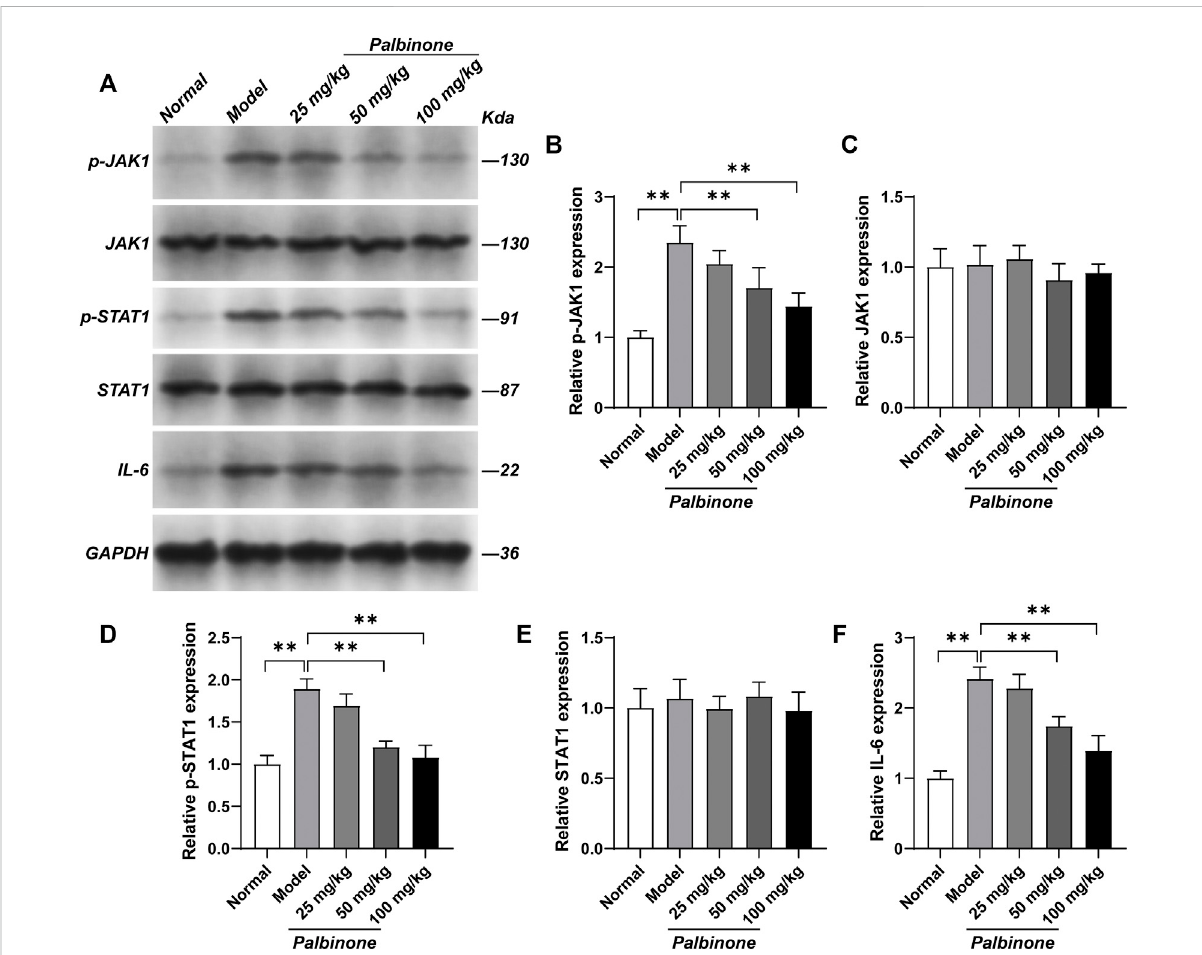
FIGURE 7 The effects of PB on JAK1-STAT1 signalling pathway in collagen-induced arthritis rats. Rats were given via intradermal injection of 100 µl of emulsioncomposedofequal partsofCFAand2mg/mlofbovinetypeIIcollagenatthebaseofthetailonday0toinducetheprimaryimmunization, then they were given the boost immunization consisting of 100 µl of the same emulsion on day 7. Rats were oral gavaged with 25, 50, 100 mg/kg PB for28 days.Theexpression ofp-JAK1 (A,B) ,JAK1 (A, C) ,p-STAT1 (A,D) ,STAT1 (A, E) and IL-6 (A, F) insynovium weredetectedbyWesternBlot. Results were mean ± SD for six individual experiments. * p < 0.05, ** p <